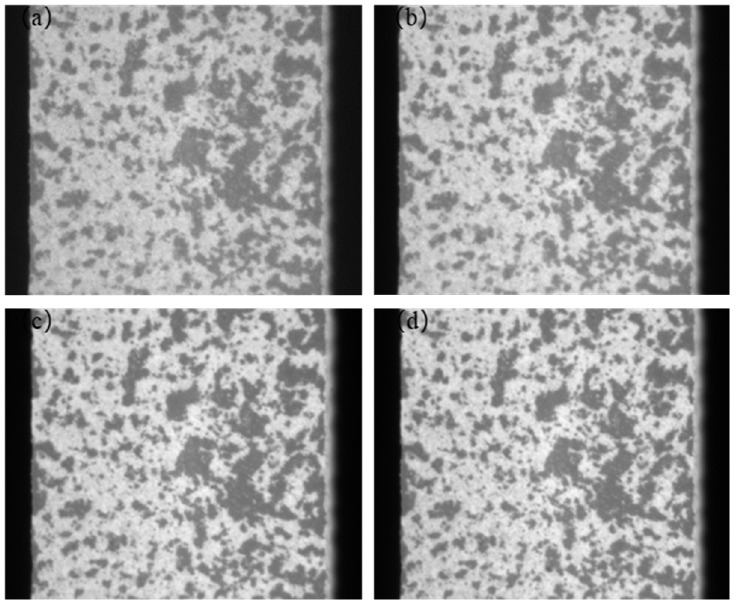
Figure 11. Speckle patterns images captured by UV system at different temperatures: ( a ) 1173 K, ( b ) 1273 K, ( c ) 1373 K and ( d ) 1473 K.